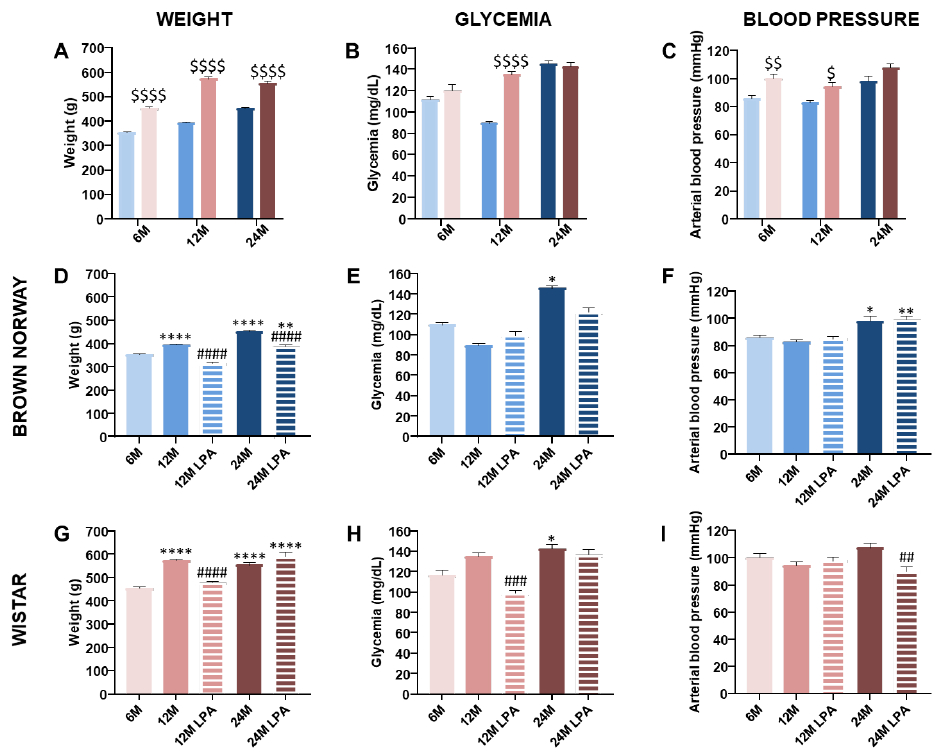
Figure 2. Evolution of the animal weight ( A , D , G ), glycemia 2.5 h after glucose absorption ( B , E , H ), and arterial blood pressure ( C , F , I ) over time with (hatched bars) or without (solid bars) LPA treatment. The results were obtained for both BN (in blue) and Wistar (in pink) strains for 6 month old (6 M), 12 month old (12 M), and 24 month old (24 M) rats previously fed a diet supplemented with α -lipoic acid (0.5%) for 4 weeks (LPA) or not. The results were compared between the two strains ( A – C ) or within the BN strain ( D – F ) or Wistar strain ( G – I ). Error bars represent the standard error of the mean. Statistical analyses were performed revealing significant differences between the two strains for each age group ($ p < 0.05; $$ p < 0.01; $$$$ p < 0.0001 vs. BN strain) or within each strain during skin aging when compared to the 6 month condition (* p < 0.05; ** p < 0.01; **** p < 0.0001) and after LPA treatment compared to age-matched untreated condition (## p < 0.01; ### p < 0.001; #### p < 0.0001).